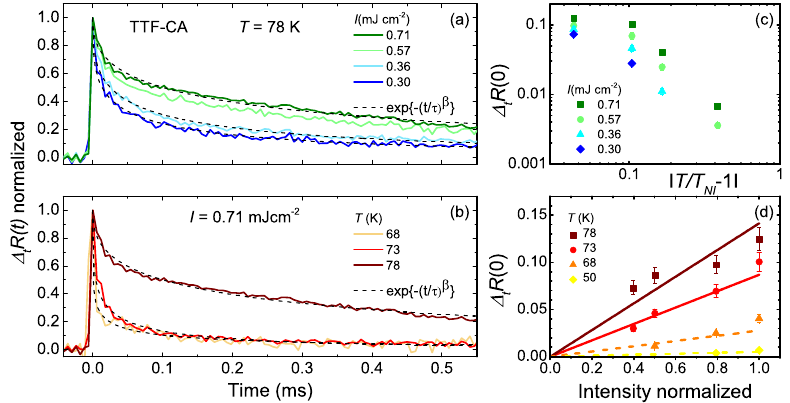
Figure 25. ( a , b ) Normalized ∆ t R ( t ) for various laser intensities recorded at ν = 1390 cm − 1 for T = 78 K and for different temperatures for I = 0.71 mJ/cm 2 . The time profile can be successfully fitted by a Kohlrausch–Williams–Watt (KWW) function exp {− ( t / τ ) β } (dashed lines); ( c ) Absolute value of ∆ t R for different laser intensities and temperatures observed immediately after the photo excitation; ( d ) ∆ t R as a function of the normalized laser intensity for temperatures between 50 K and 78 K. Adapted from Ref. [83].